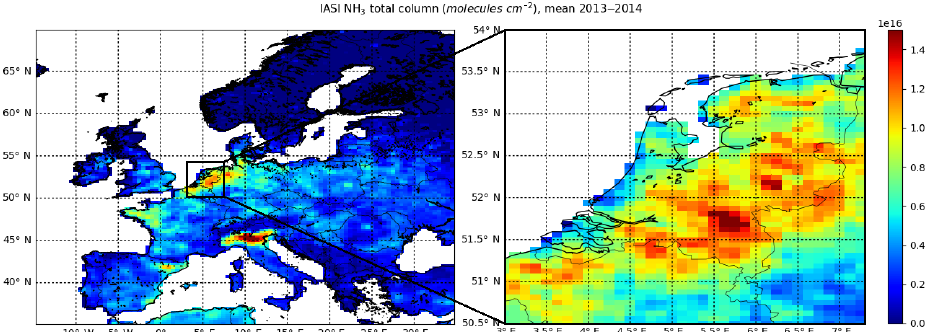
Figure 1. The annual mean NH 3 total column concentration in 2013–2014 as observed by IASI-A in Europe (regridded to 0.50 ◦ longitude by 0.25 ◦ latitude) and the Netherlands (regridded to 0.125 ◦ longitude by 0.0625 ◦ latitude).